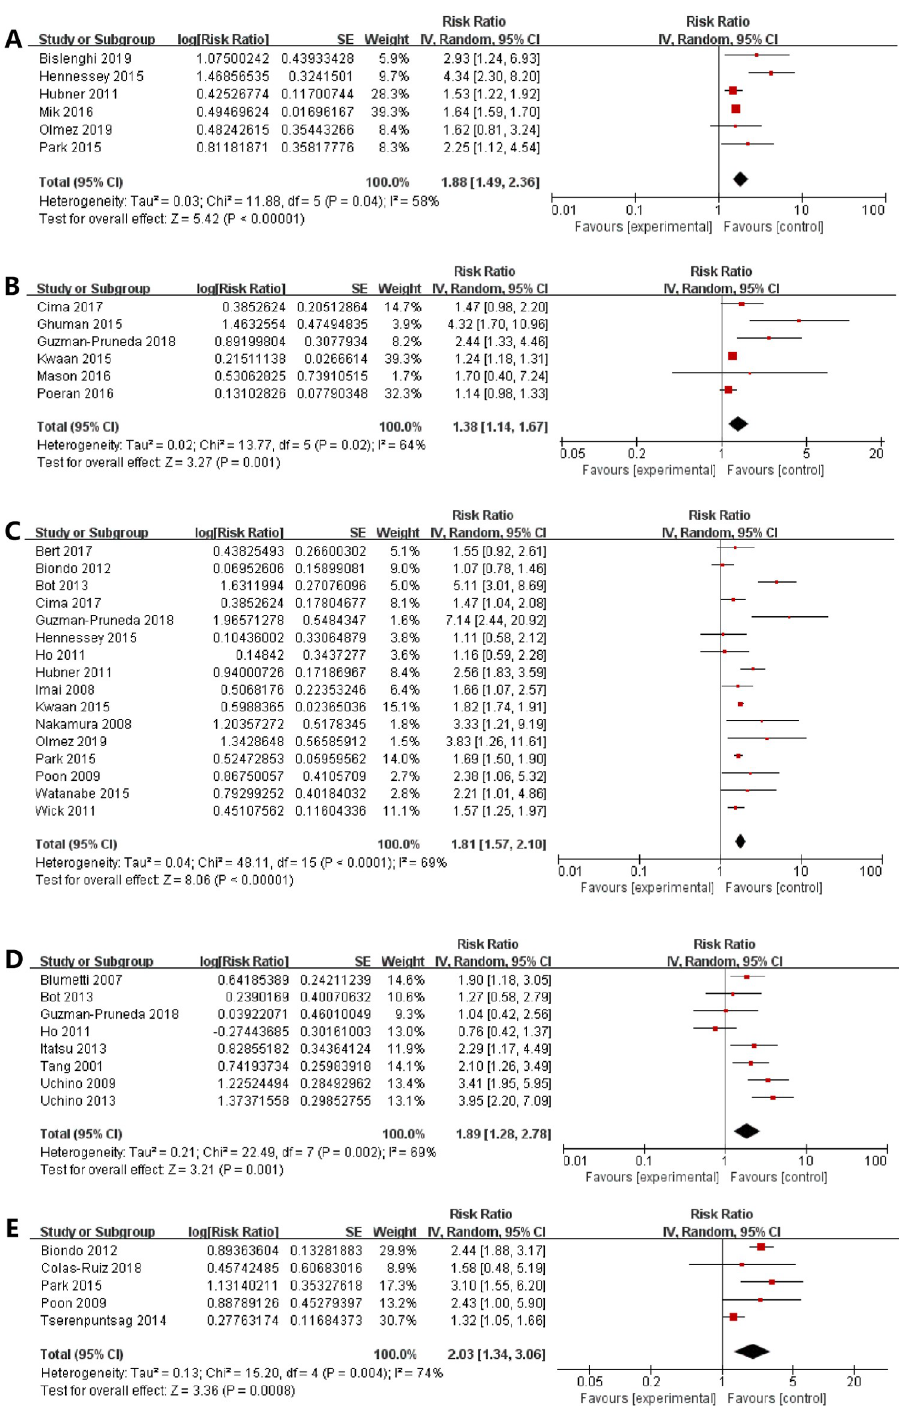
Fig 3. The forest plots showed that the correlations between the risk of SSIs with (A) operative time ( � 180min), (B) cigarette smoking, (C) open surgery, (D) stoma formation, (E) blood transfusion.